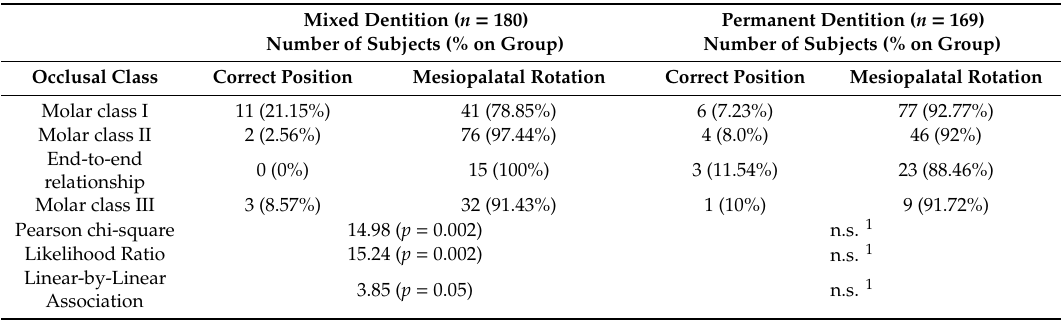
Table 3. Distribution of data for occlusal Angle class and presence of rotated UFM, with analyses of